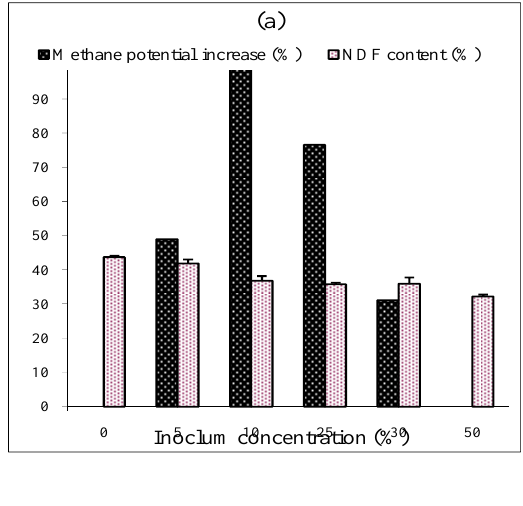
Figure 2. Methane yield and NDF content of SLDR after two-steps pre-treatment with (a) 10% CCHT-1 inoculum followed by different T. reesei inocula concentrations (% wet weight of SLDR), (b) 25% T. reesei followed by different CCHT-1 inocula concentrations (% wet weight of